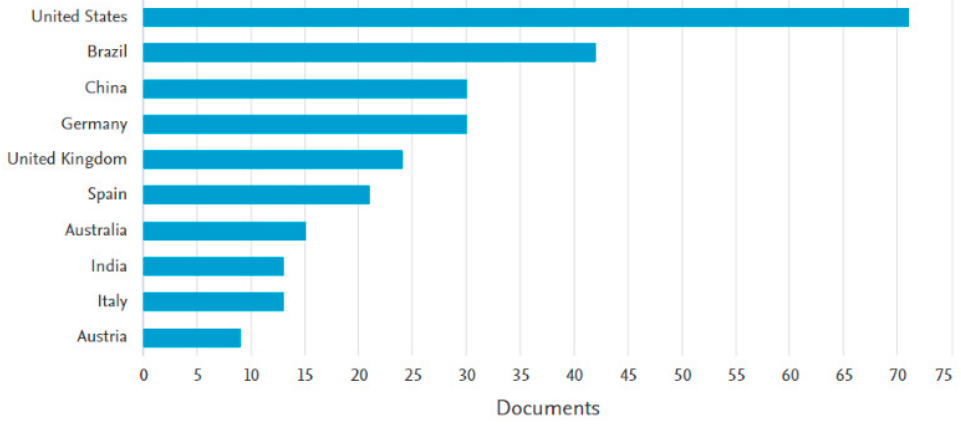
Figure 2. Documents by country or territory (10 most representative).